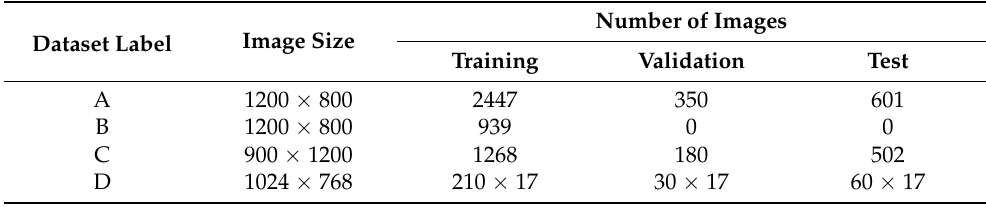
Table 1. Quantitative details of Datasets A, B, C, and D. Dataset